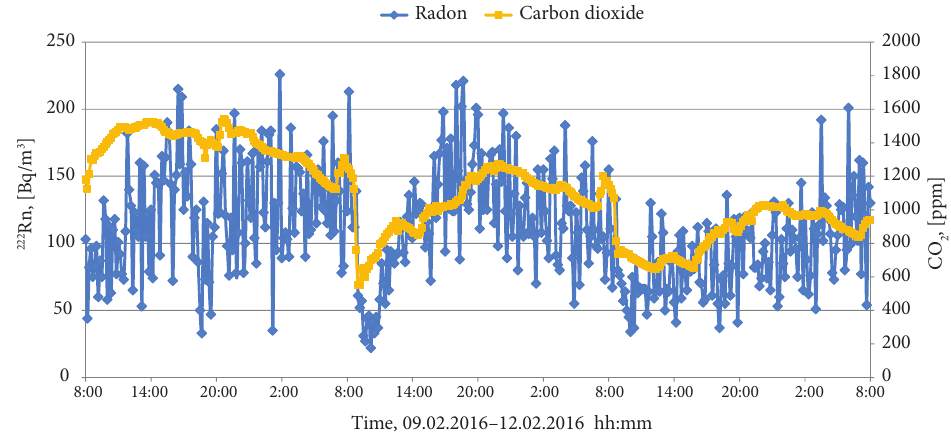
Figure 4. Indoor radon and carbon-dioxide concentration in 2016 winter at Gö3 house in case of 3 day measurement, in addition to various